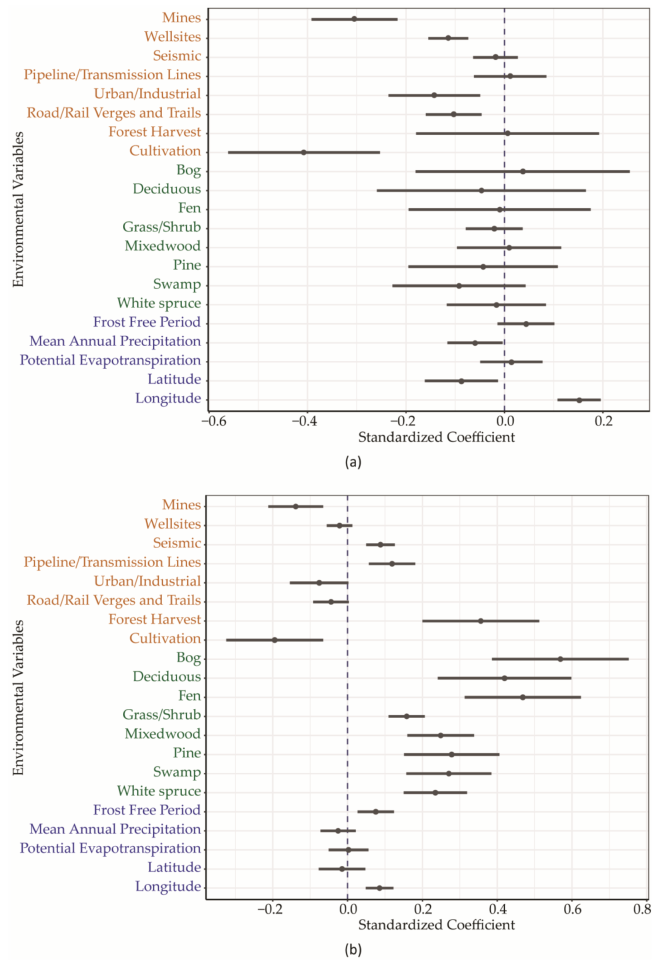
Figure 2. Linear regression plots for oribatid mite ( a ) total abundance and ( b ) Shannon’s diversity, against 21 land cover and climate–space variables in the oil sands region of Alberta, Canada. Standardized coefficients (i.e., beta weights) allow a better comparison of the relative influence of environmental variables on response variables. For example, total abundance is expected to respond strongly (negatively) to cultivation and mines compared to seismic lines. Word colour: yellow = human footprint; green = natural land cover; blue =